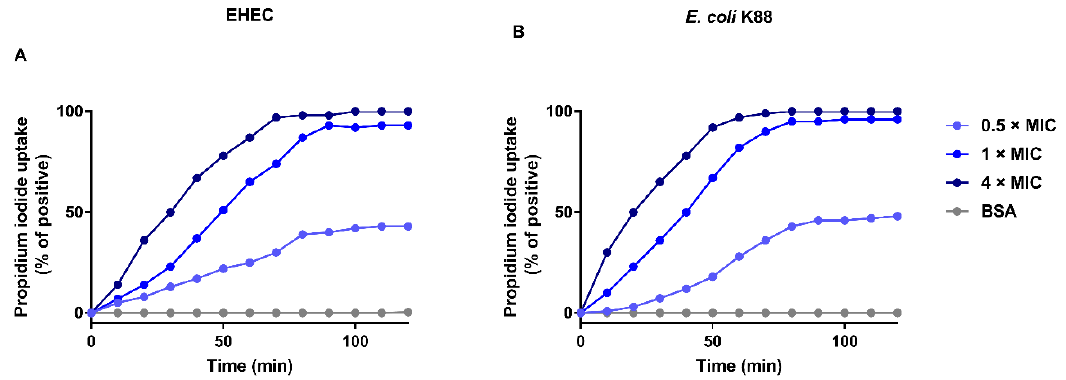
Figure 4. Propidium iodide uptake by enterohemorrhagic EHEC ( A ) and E. coli K88 ( B ) in the presence of purified recombinant EF-1, 0.05% ( w / v ) SDS the maximum fluorescence, BSA as a negative control. ( A ) 0.5, 1 and 4 × MIC of purified EF-1 against EHEC were the concentration of 3.125, 6.25, and 25 μM. ( B ) 0.5, 1, and 4 × MIC of purified EF-1 against E. coli K88 were the concentration of 1.5, 3.125, and 6.25 μM.